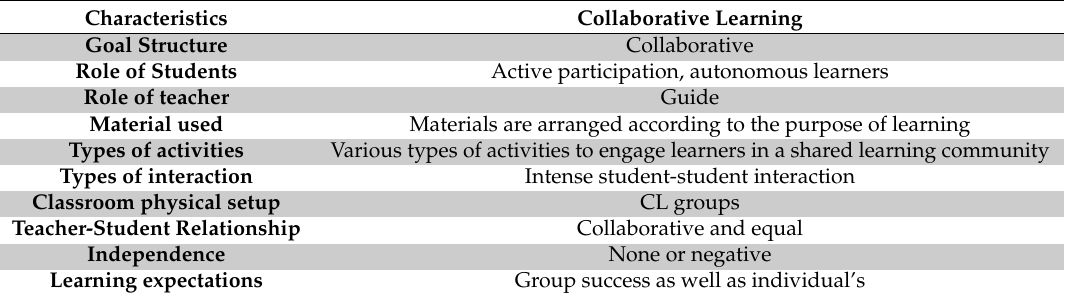
Table 1. Characteristics of Collaborative Learning.